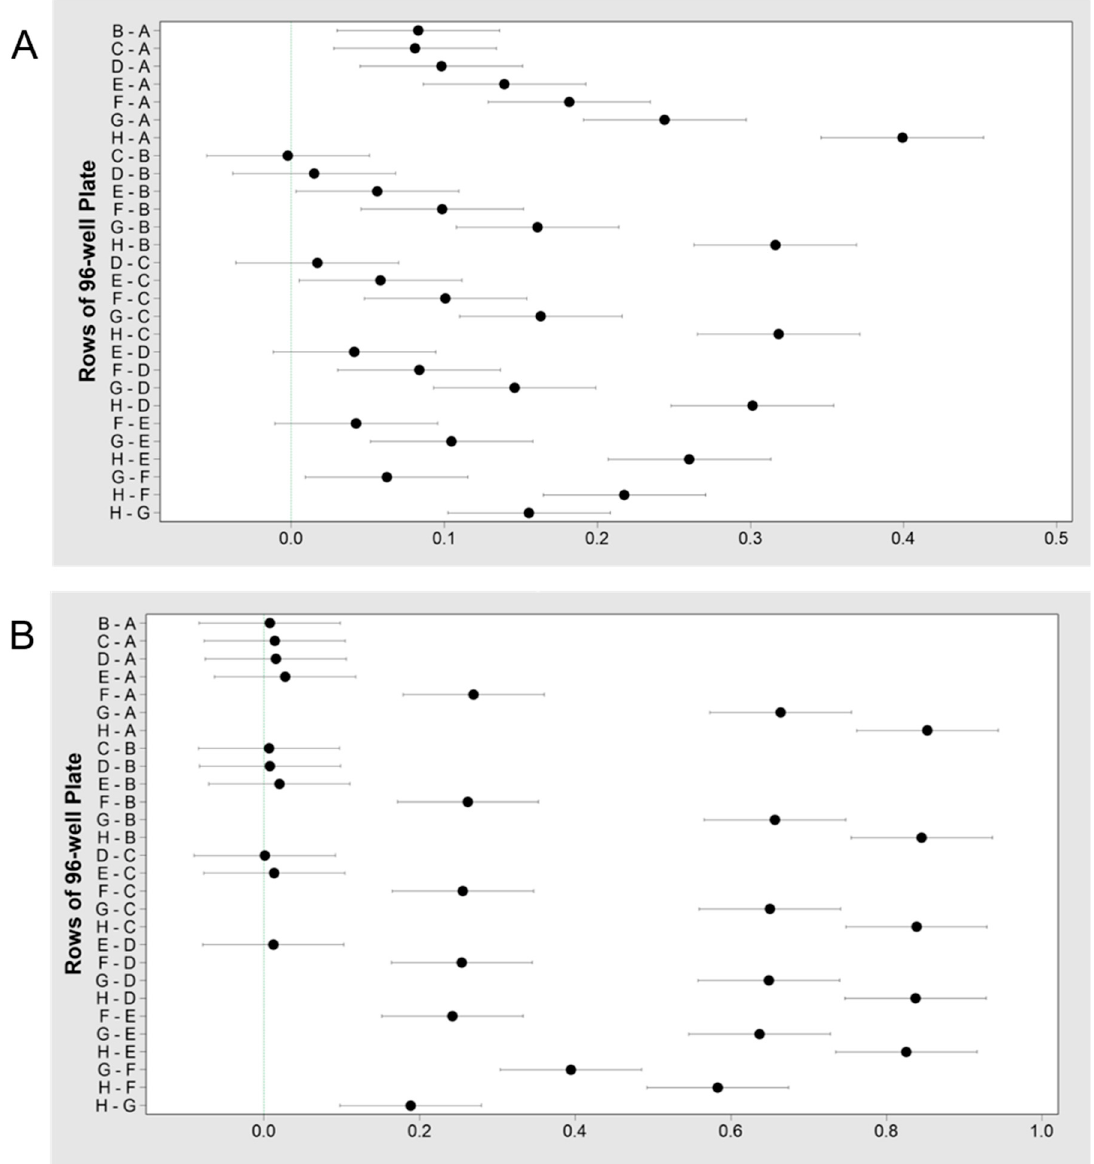
Figure 2. Fisher individual 95% confidence intervals for the MIC values from the challenge plate of A. hydrophila containing ( A ) cotrimoxazole; the MIC is determined to be between 1000 and 500 μ g/mL (rows A and B) due to lack of growth and a significant difference in the absorbance between rows A and B, but not rows B and C, ( B ) neomycin; the MIC is determined to be between 62.5 and 32.3 μ g/mL (rows E and F) due to lack of growth and a significant difference in the absorbance between rows E and F.